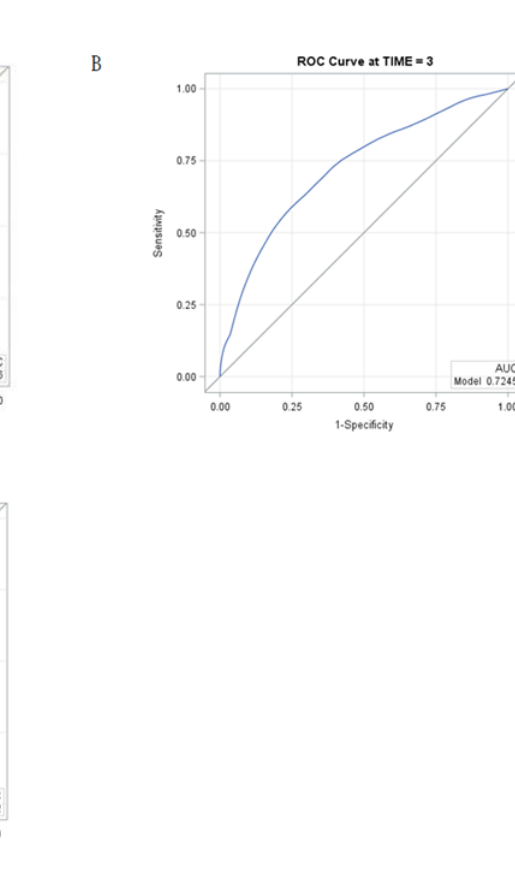
Figure 3. The integrated time-dependent area under receiver operating characteristic (ROC) curve and the 95% confidence limits for the predication model.